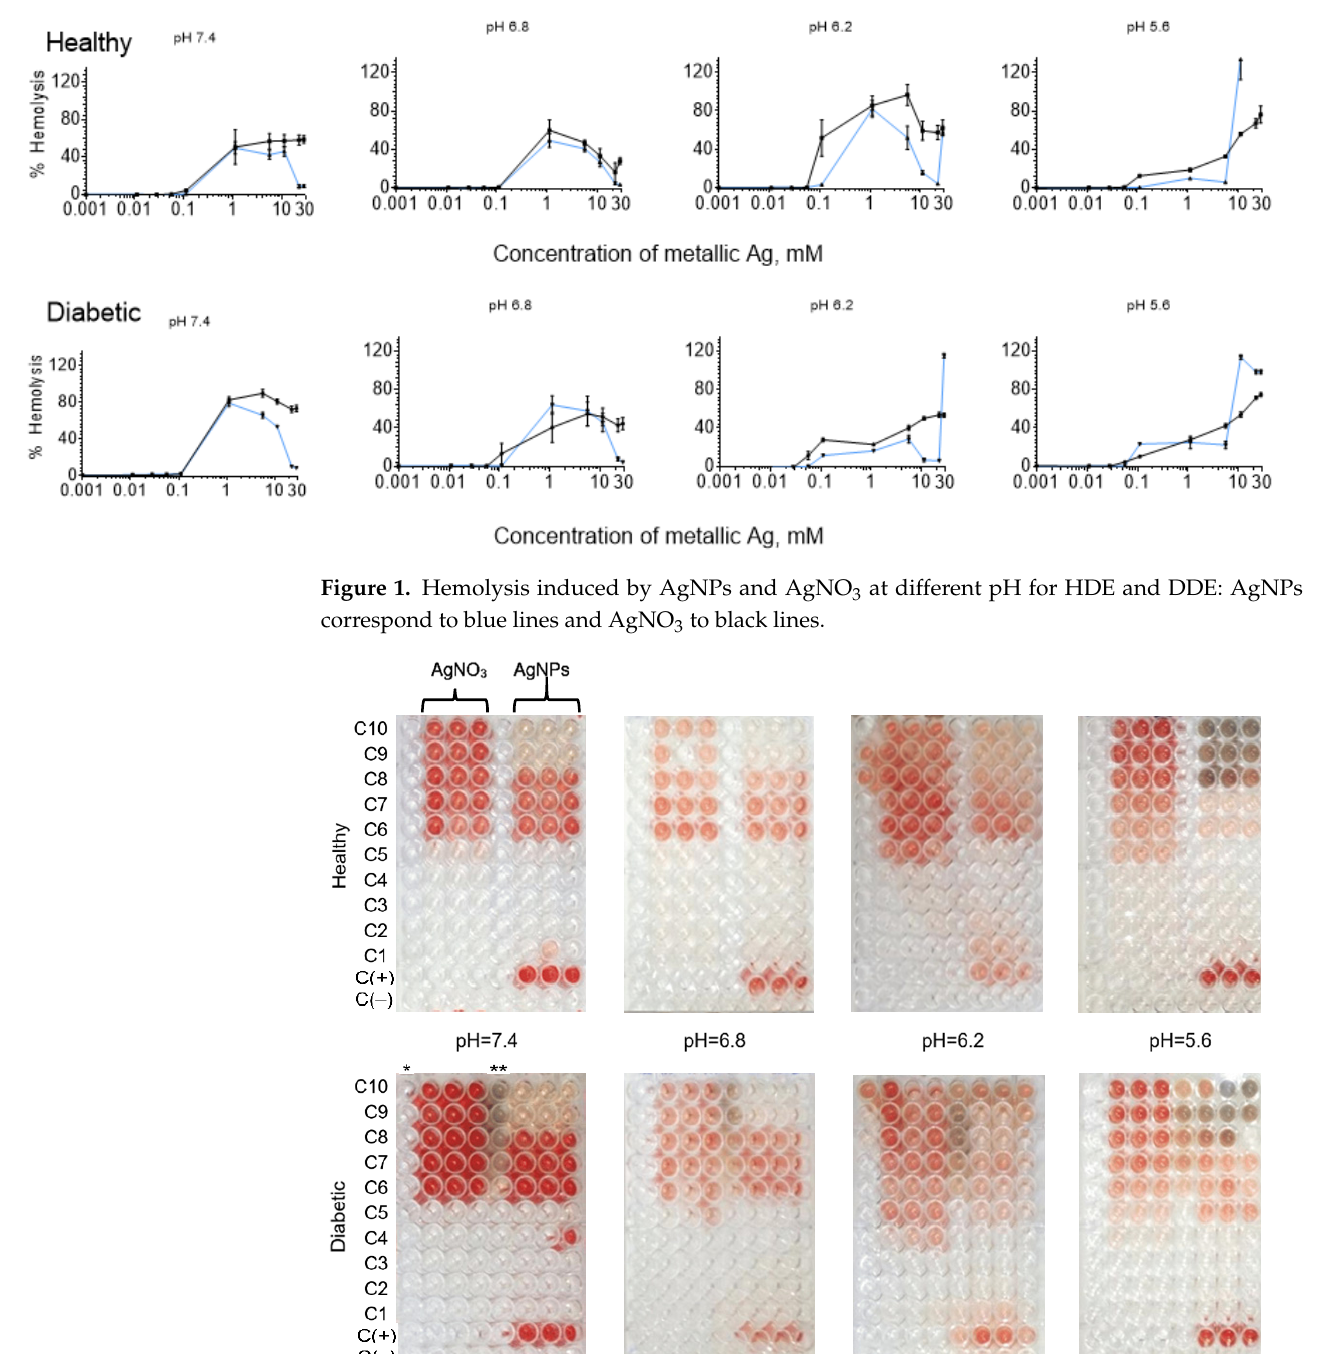
Figure 2. Photograph of 96-well plates of hemolyzed samples with triplicates for diabetic and healthy donor erythrocytes at different pH and concentrations. Concentrations from C1 to C10 for AgNPs and AgNO 3 , at 0.001, 0.011, 0.028, 0.056, 0.111, 1.113, 5.565, 11.129, 22.258, and 27.823 mM, correspond to metallic silver concentrations, respectively. Positive (C+ Triton X-100) and negative (C − with erythrocytes) controls are included. (*) Represents AgNO 3 without erythrocytes and (**) AgNPs without